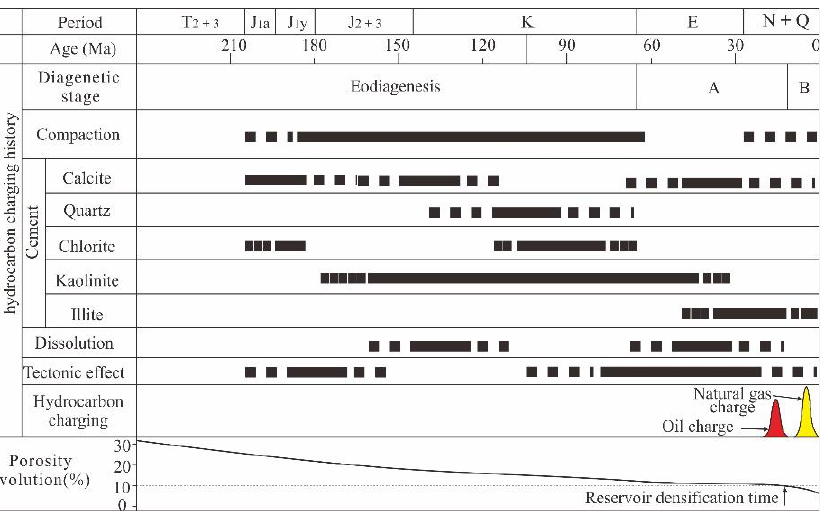
Figure 12. Diagenesis and porosity evolution of the J 1 a Formation. A is A substage of mesogenetic diagenesis; B is B substage of mesogenetic diagenesis.